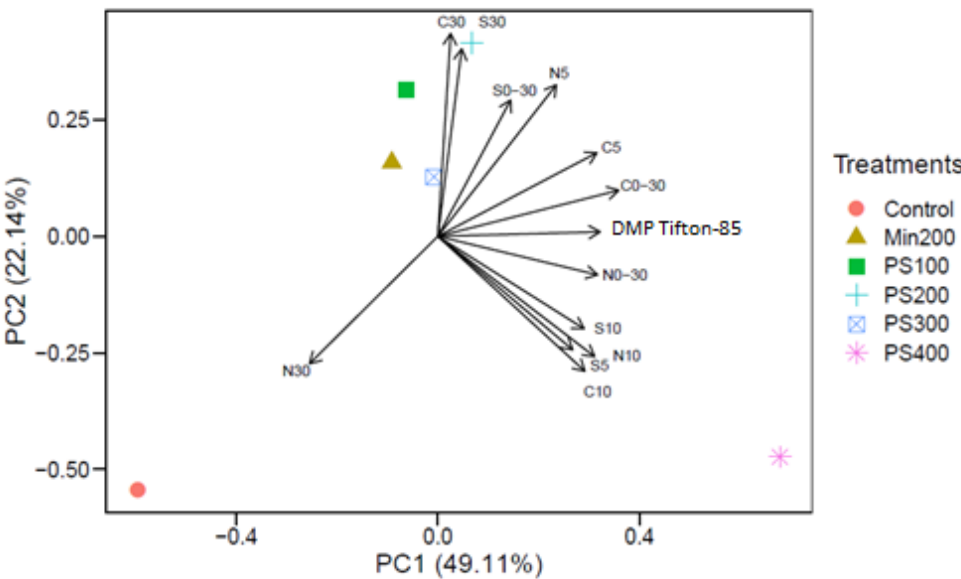
Figure 1. Total dry matter production of Tifton-85 ( Cynodon sp.) grown under applications of increasing doses of pig slurry applications (PS) and urea in the 2012/2013 to 2017/2018 agricultural year. Ibirubá, RS, Brazil, 100 = 100 kg ha − 1 of N using pig slurry (PS); 200 = 200 kg ha − 1 of N using PS; 300 = 300 kg ha − 1 of N using PS; 400 = 400 kg ha − 1 of N using PS; urea = 200 kg ha − 1 of N using urea; 0 = control, no fertilizer application.